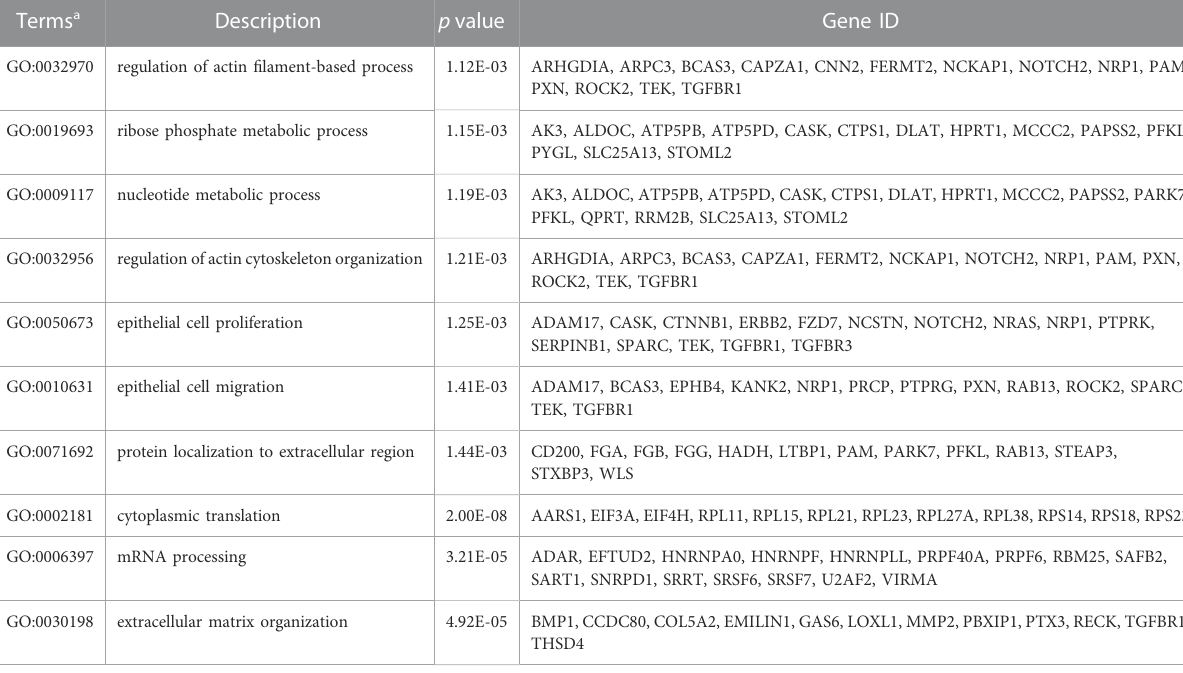
TABLE 2 ( Continued ) Cell surfaceome analysis of EP-sEV treatment reveals key biological processes reprogrammed in human trophectoderm